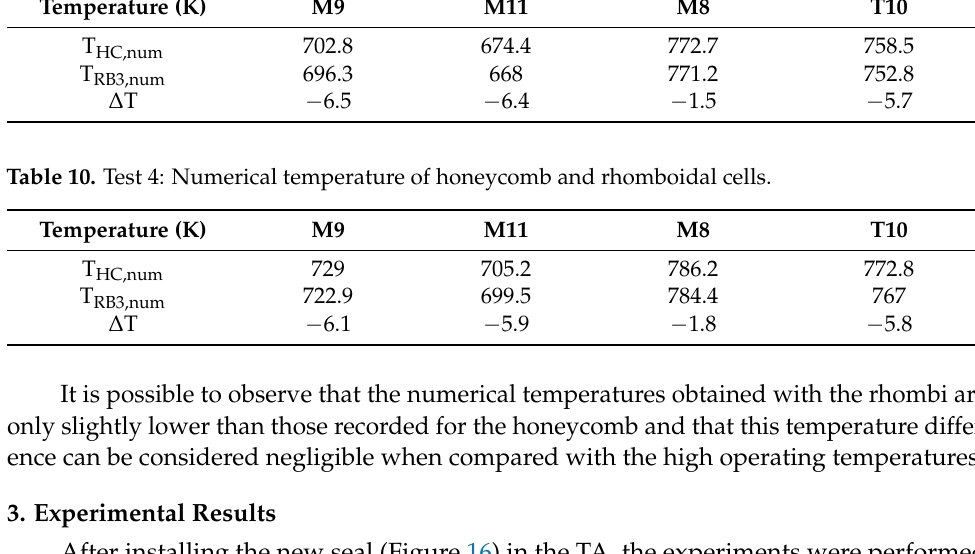
Table 11. Experimental inlet conditions for the rhomboidal cells. Test